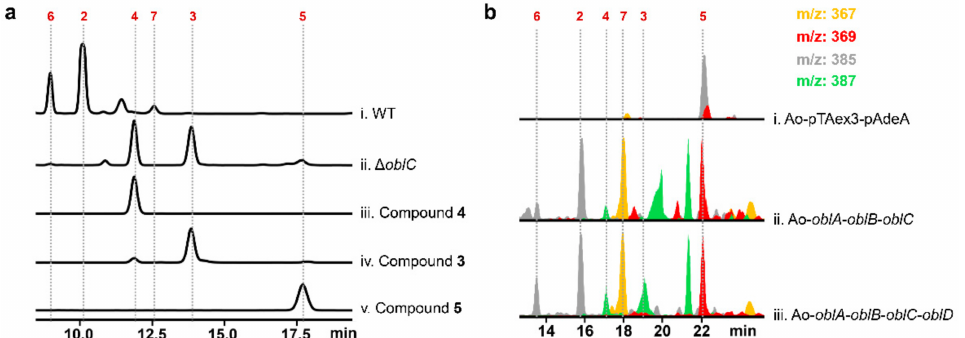
Figure 3. Confirmation of oblC Au gene function. ( a ) HPLC profiles of standards and culture extracts from wild-type strain and ∆ oblC mutant at the wavelength of 234 nm. ( b ) LC–ESI-HRMS analysis of culture extracts from A. oryzae transformants. Peaks of m/z 367(orange), m/z 369 (red), m/z 385 (gray) and m/z 387 (green) were